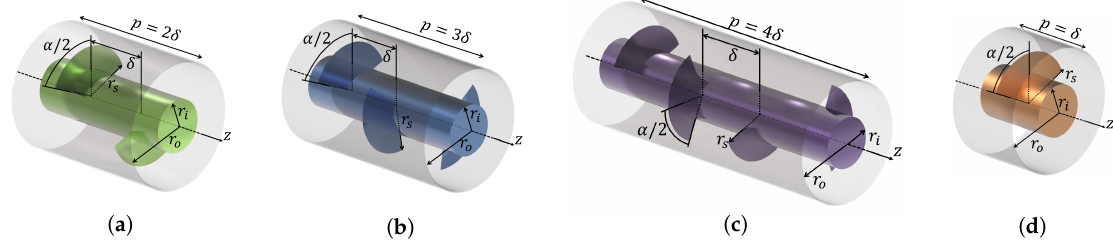
Figure 2. Analyzed periodically loaded coaxial transmission lines: ( a ) 2-, ( b ) 3-, and ( c ) 4-fold twist-symmetric structures and ( d ) conventional periodic structure.